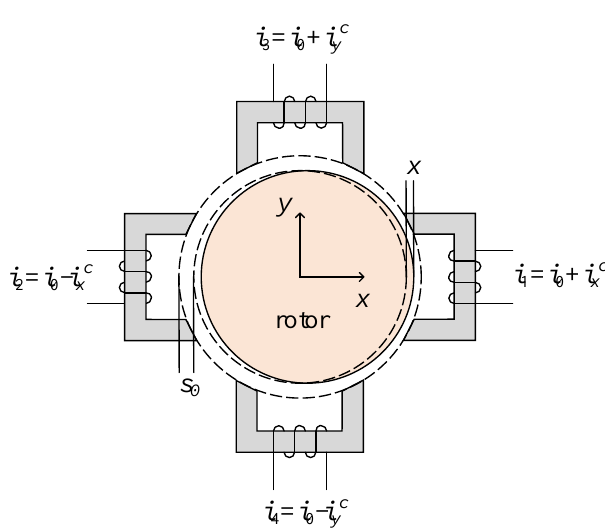
Figure 1. Active magnetic bearing suspension incorporating four electromagnetic